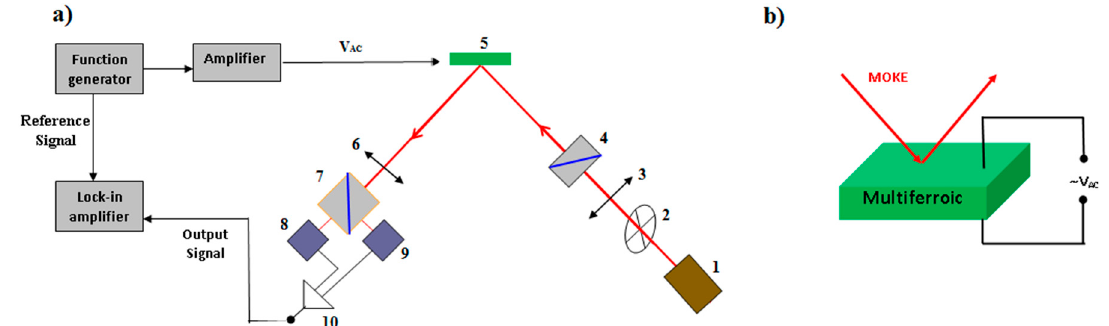
Figure 3. ( a ) Schematic diagram of a MOKE measurement system modified for multiferroic coupling measurements. Note the absence of the DC electromagnet. Parts of the system are: 1. CW or pulsed Laser source; 2. Beam chopper (not required if AC laser source ort if V ac excitation signal is used as the reference signal for the MOKE lock-in detection; 3. λ /2 wave plate; 4. Polarizer; 5. Sample; 6. λ /4 wave plate; 7. Polarizer/Analyser; 8. Photodetector 1; 9. Photodetector 2; 10. Differential amplifier and signal output. ( b ) Diagram showing the multiferroic sample under MOKE test while subjected to electrical excitation, i.e., applied electric field.